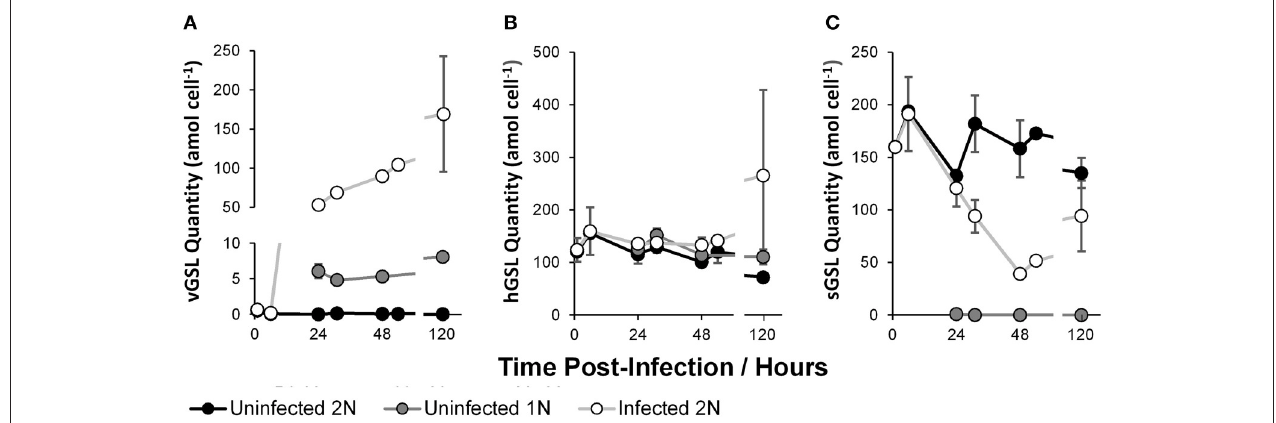
FIGURE 4 | Glycosphingolipid quantity per E. huxleyi cell: Viral glycosphingolipid (vGSL, A); Host glycosphingolipid (hGSL, B); Sialic-acid glycosphingolipid (sGSL, C). Data represent the mean average of two biological replicates with error bars of one standard deviation. See Supplementary Table 1 for tabulated